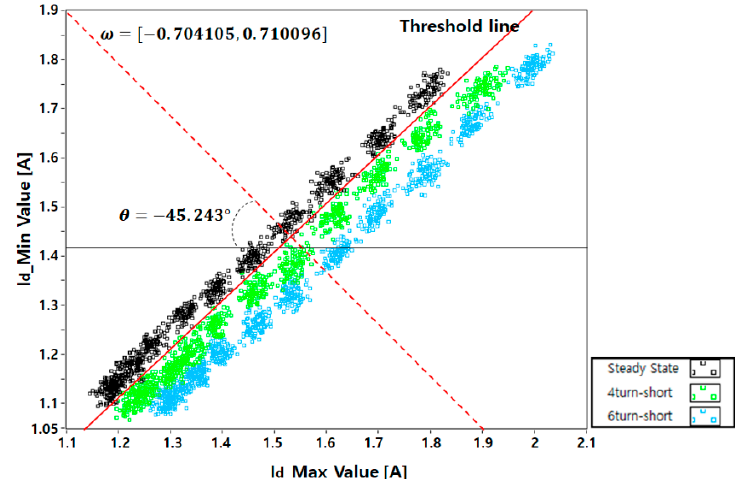
Figure 14. Linear discriminant analysis (LDA) application and critical line according to general turn short.